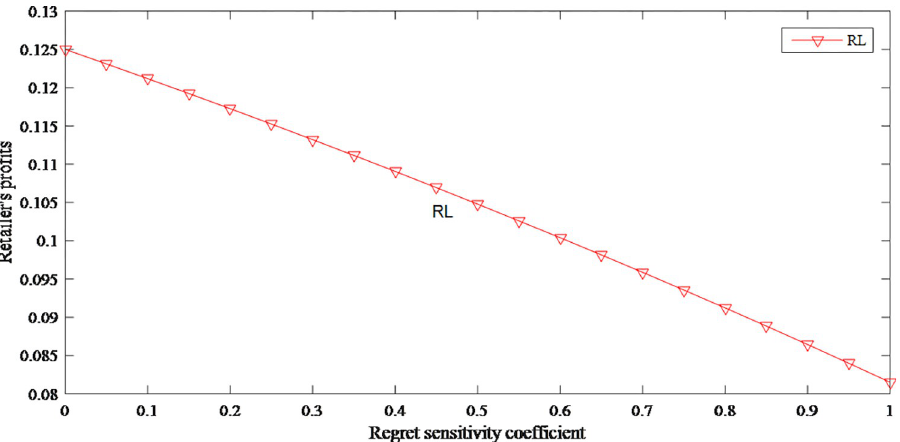
Fig 5. The impact of anticipated regret on retailer’s